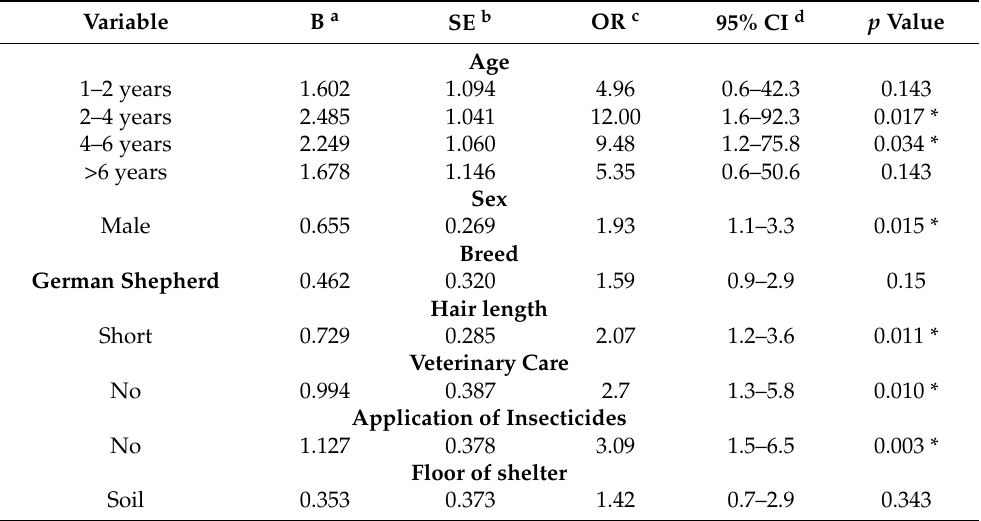
Table 2. Multivariable logistic analysis for risk factors of Leishmania infantum infection in dogs. Variable B a SE b OR c 95% CI